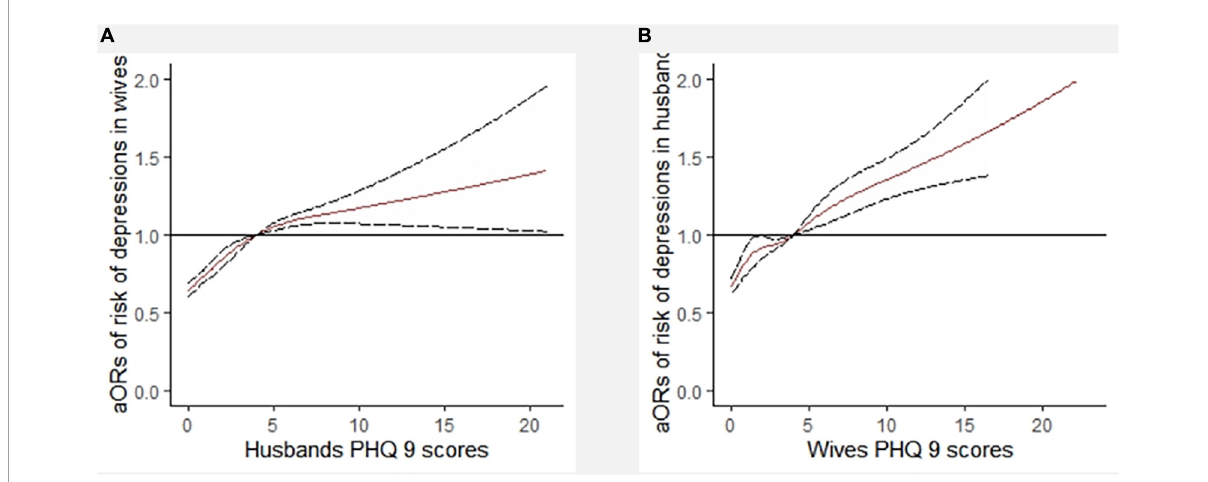
FIGURE6 Dose-response relationship between PHQ-9 scores of husbands (A) and depression symptoms of wives (6 knots) (B) . aOR, adjusted odds ratio; PHQ-9, 9-item Patient Health Questionnaire. Adjusted for male age, male BMI, regions, male physical activity, female age, female BMI, current pregnancy, and female physical